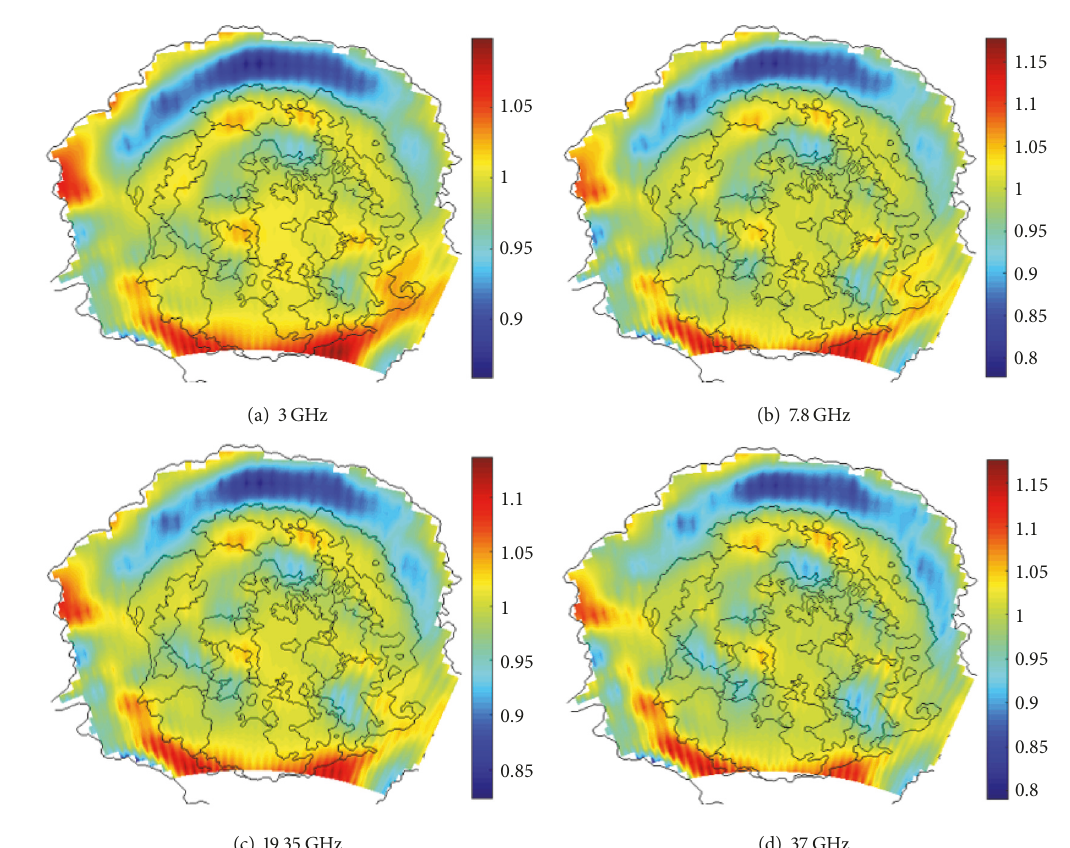
Figure 7: n T maps of the Schr¨odinger basin at 10 B